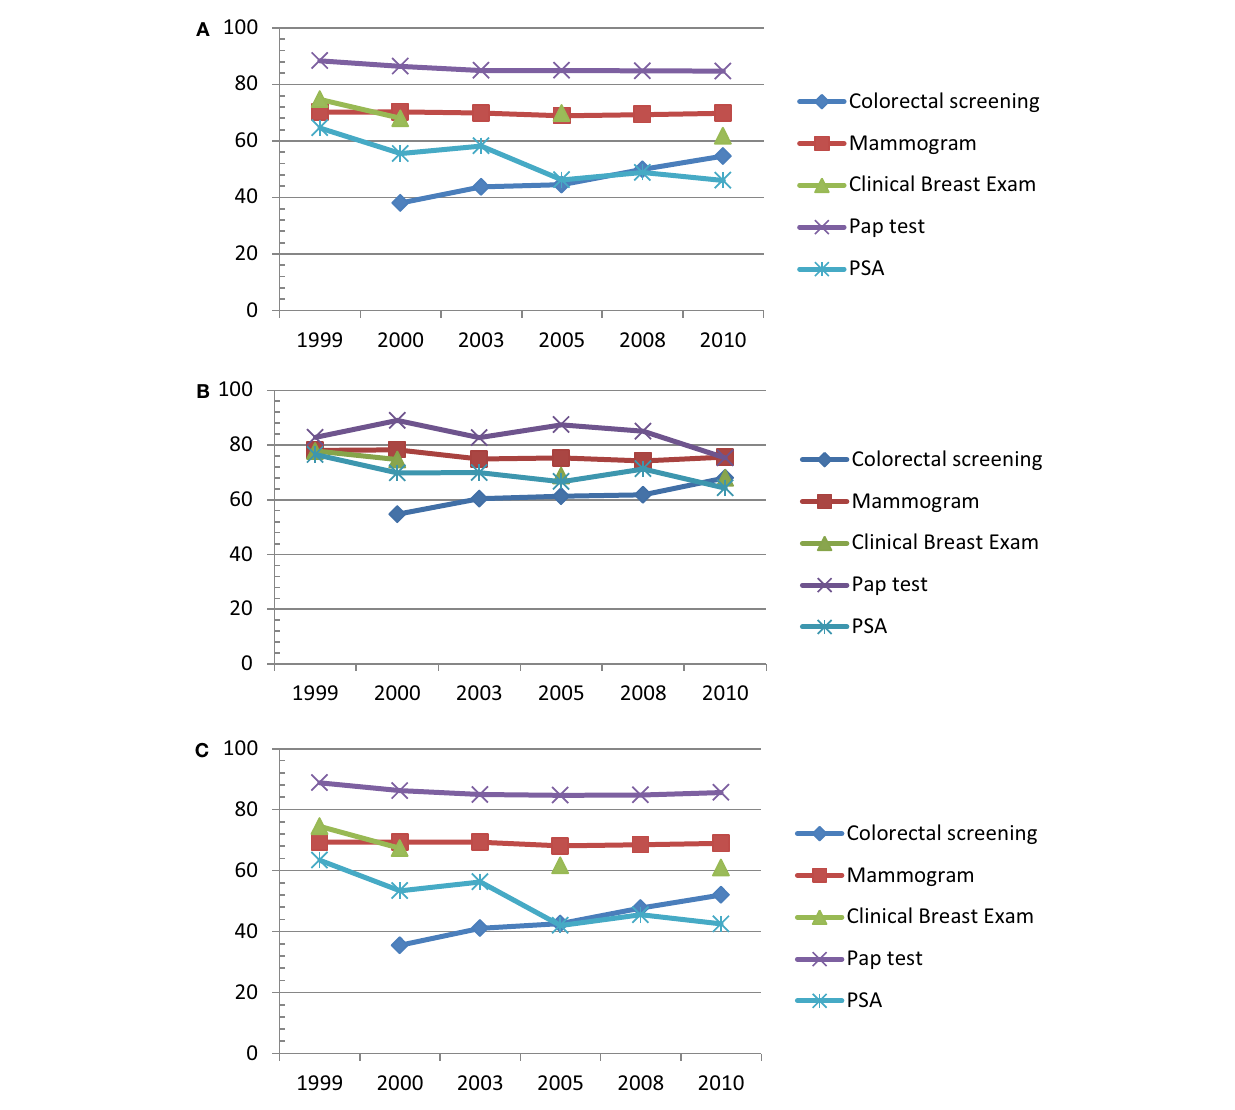
FIGURE 1 |Trend in adherence to screening among (A) the general US population ( n = 174,393), (B) US cancer survivors ( n = 12,990), (C) persons with no prior cancer history ( n =